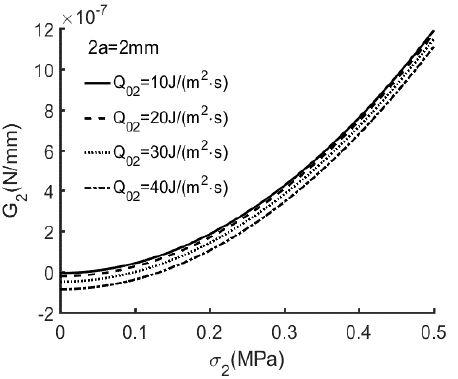
Figure 7. G 2 versus tension stress with 𝑄 02 = 10, 20, 30, 40 J/(m 2 . s) for 𝜛 𝑐 = 0 and 𝜀 = 0.01. (2 a = 2 mm).